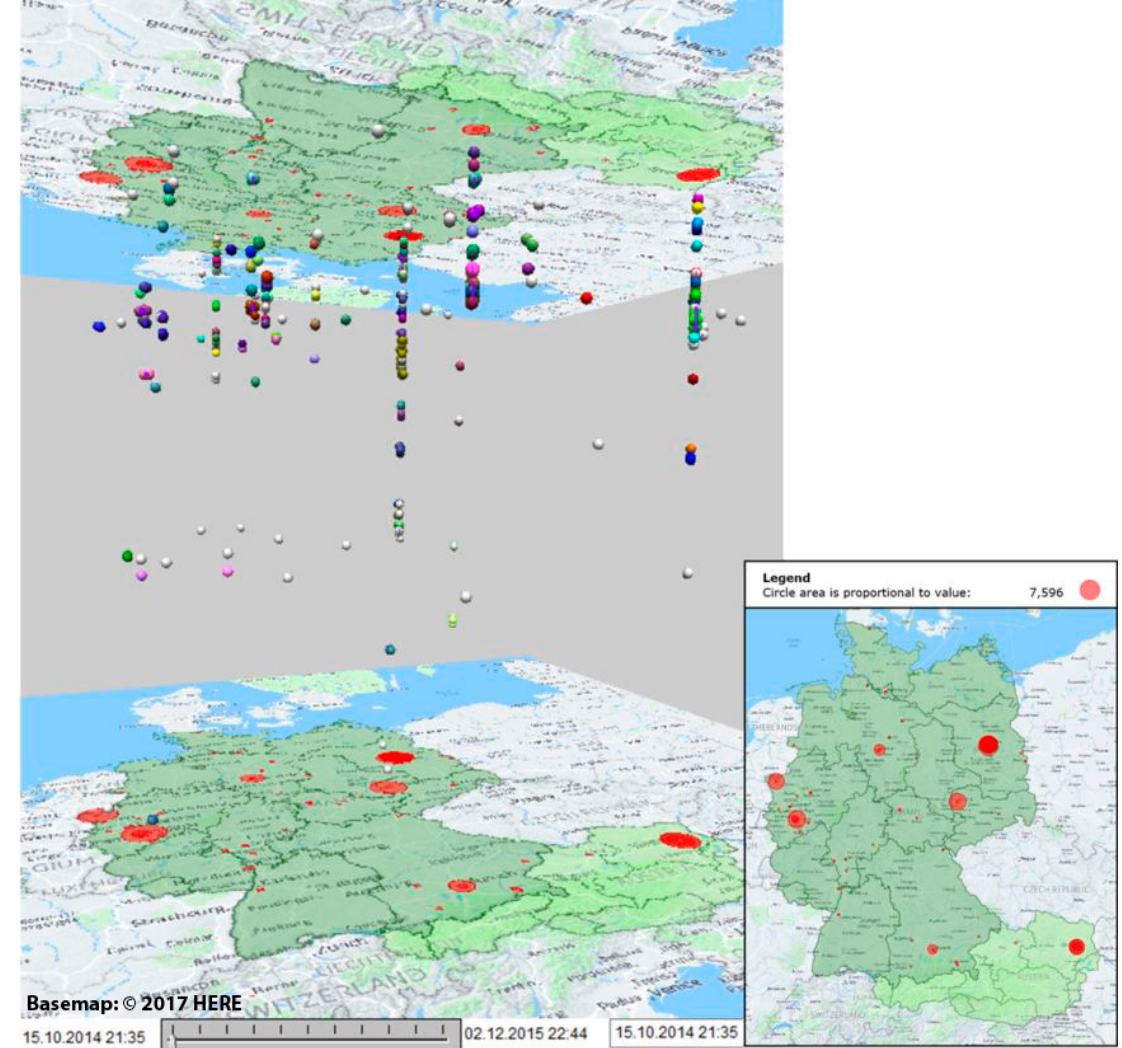
Figure 12. Density-based and distance-bounded spatio-temporal event clustering for Austria and Germany visualized in a space-time